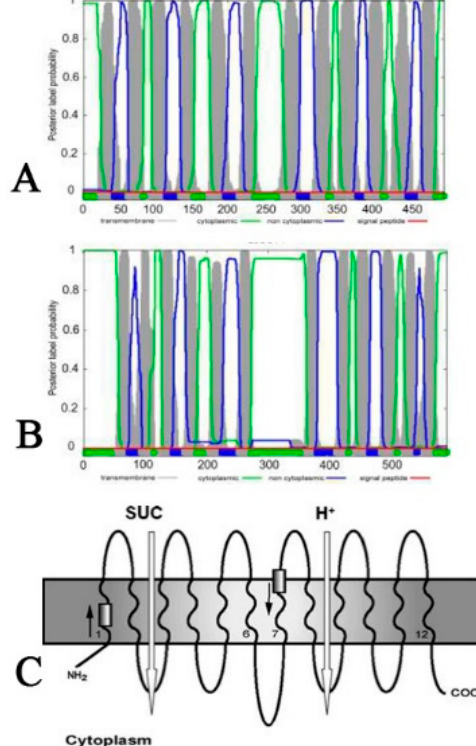
Figure 9. Two-dimensional structural models of protein LoSUT2 and LoSUT4. Among them, Figure 9A is the prediction of the transmembrane region of the LoSUT2 protein; Figure 9B is the predicted result of the transmembrane region of the LoSUT4 protein; and Figure 9C is the classical transmembrane structure of the SUT gene summarized in the reference.